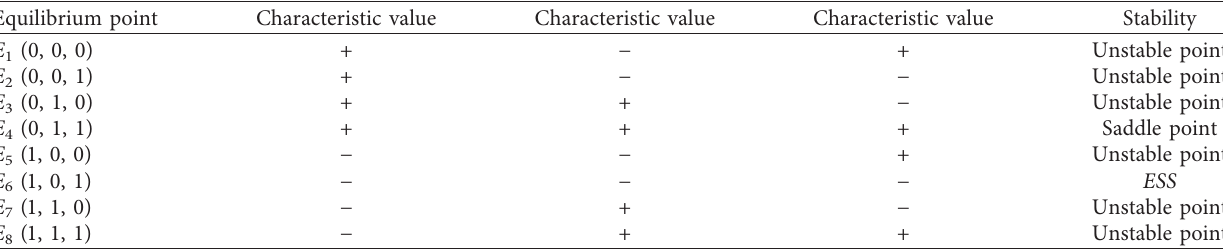
Table 4: Local stability analysis of the equilibrium